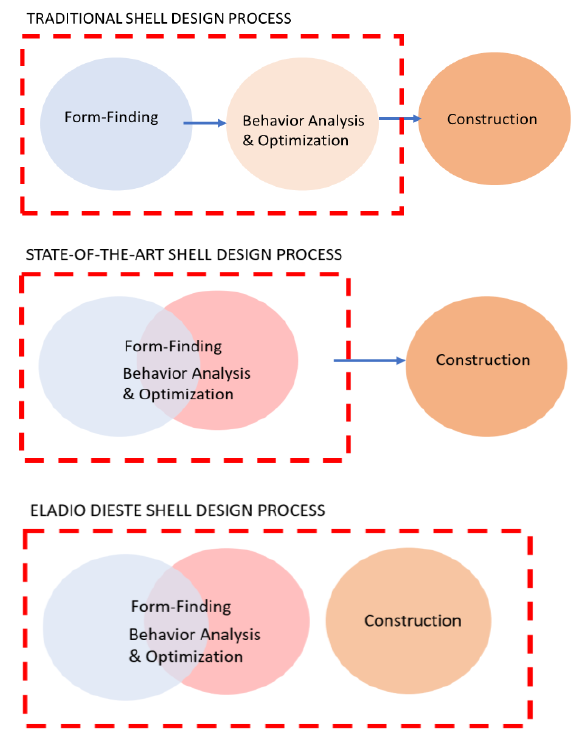
Figure 11: Confrontation of the current paradigms of thin-shell design process with Eladio Dieste’s design process for such